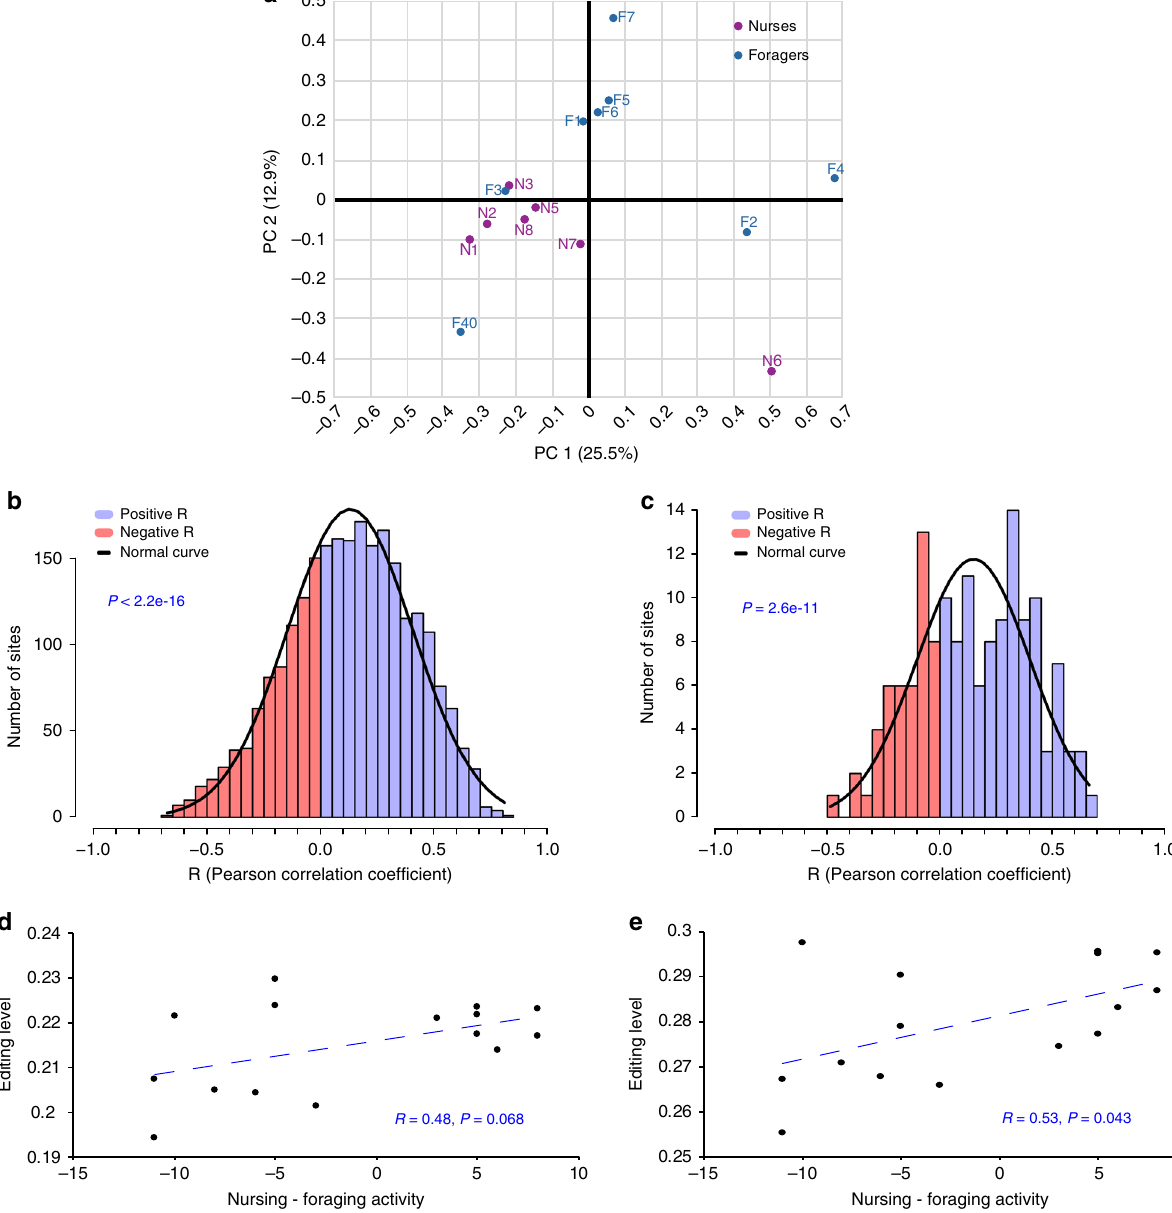
Fig. 4 RNA editing correlates with the level of nursing – foraging activity. a PCA analysis showing the clustering of bees classi fi ed as nurses or foragers based on their RNA editing level pro fi le across 149 well-covered sites within the coding region. b , c Distribution of the correlation coef fi cients between the task performance index (the number of observations of nursing activity minus the number of observations of foraging activity) and editing levels at each editing site. Blue and red bars show sites with positive and negative correlation coef fi cient, respectively. Signi fi cant enrichment of positive correlations was observed for sites in non-coding ( b , 2468 sites), as well as coding ( c , 149 sites) regions ( t -test). d , e Pearson ’ s correlation between overall editing level (index overall sites, see Methods) and task performance index for non-coding ( d ) and protein coding ( e ) sites. Source data are provided as a Source Data fi